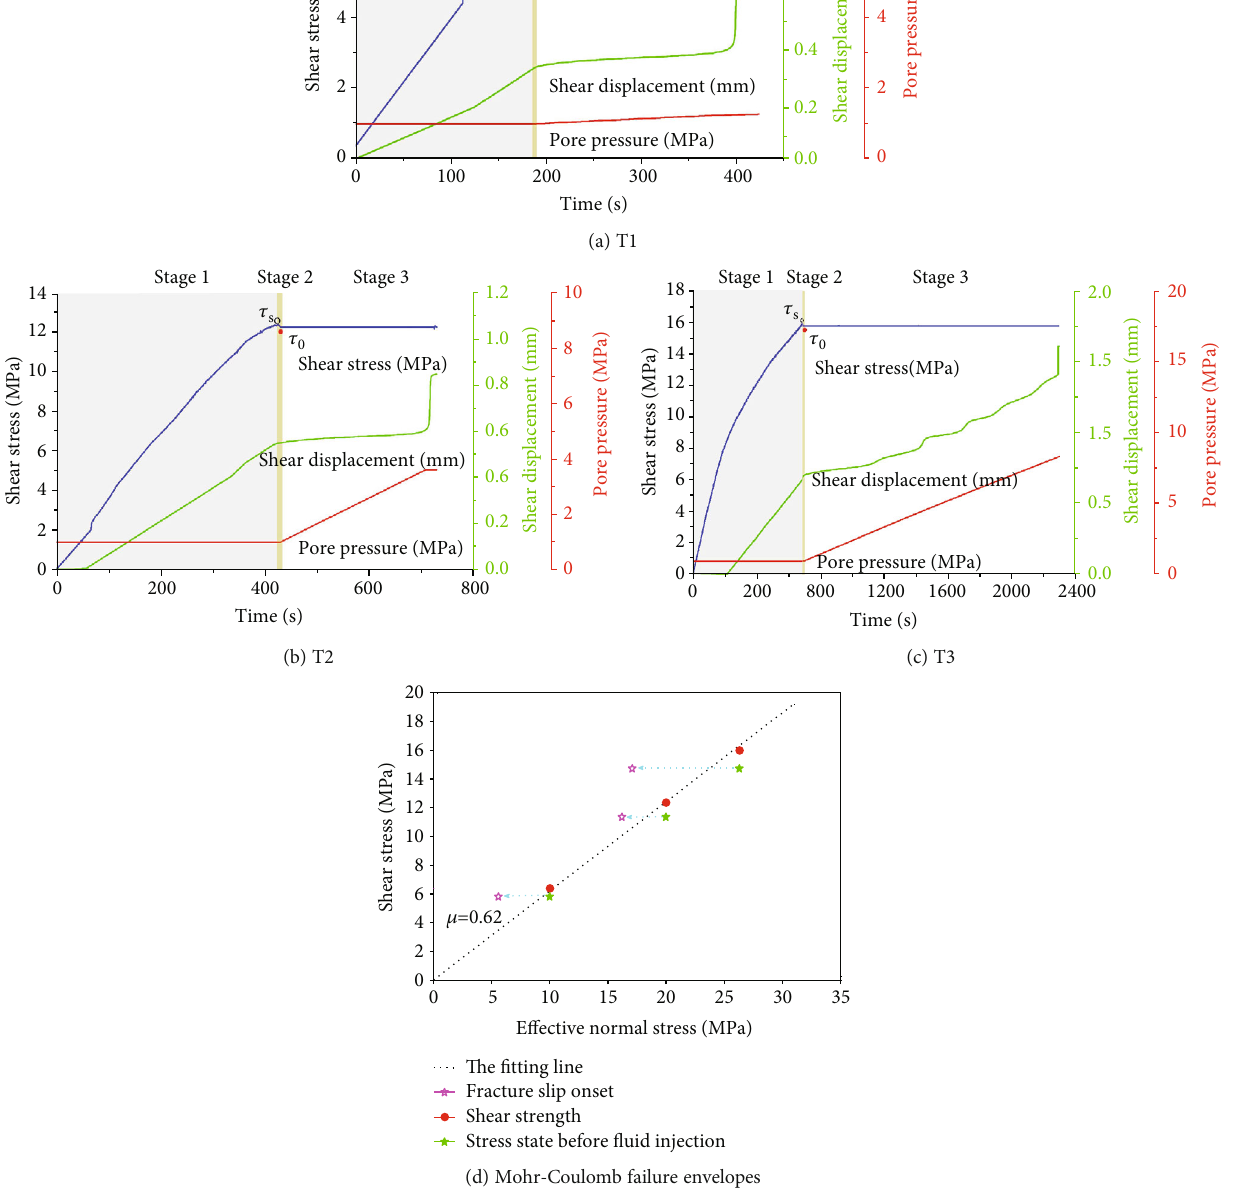
Figure 4: Stress-displacement evolution in nonstepping injection-induced shear tests. (a – c) Tests T1, T2, and T3. (d) Mohr-Coulomb failure envelopes obtained by fi tting the shear strengths (solid red circle) from the displacement-driven shear tests, and the stress states of sawcut fractures before the fl uid injection (solid green fi ve-pointed star) and at the onset of injection-driven fracture instability (solid pink fi ve- pointed star). Please notice the di ff erence in the coordinate